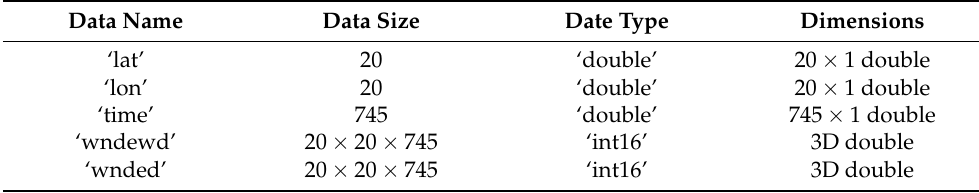
Table 2. The wind data.